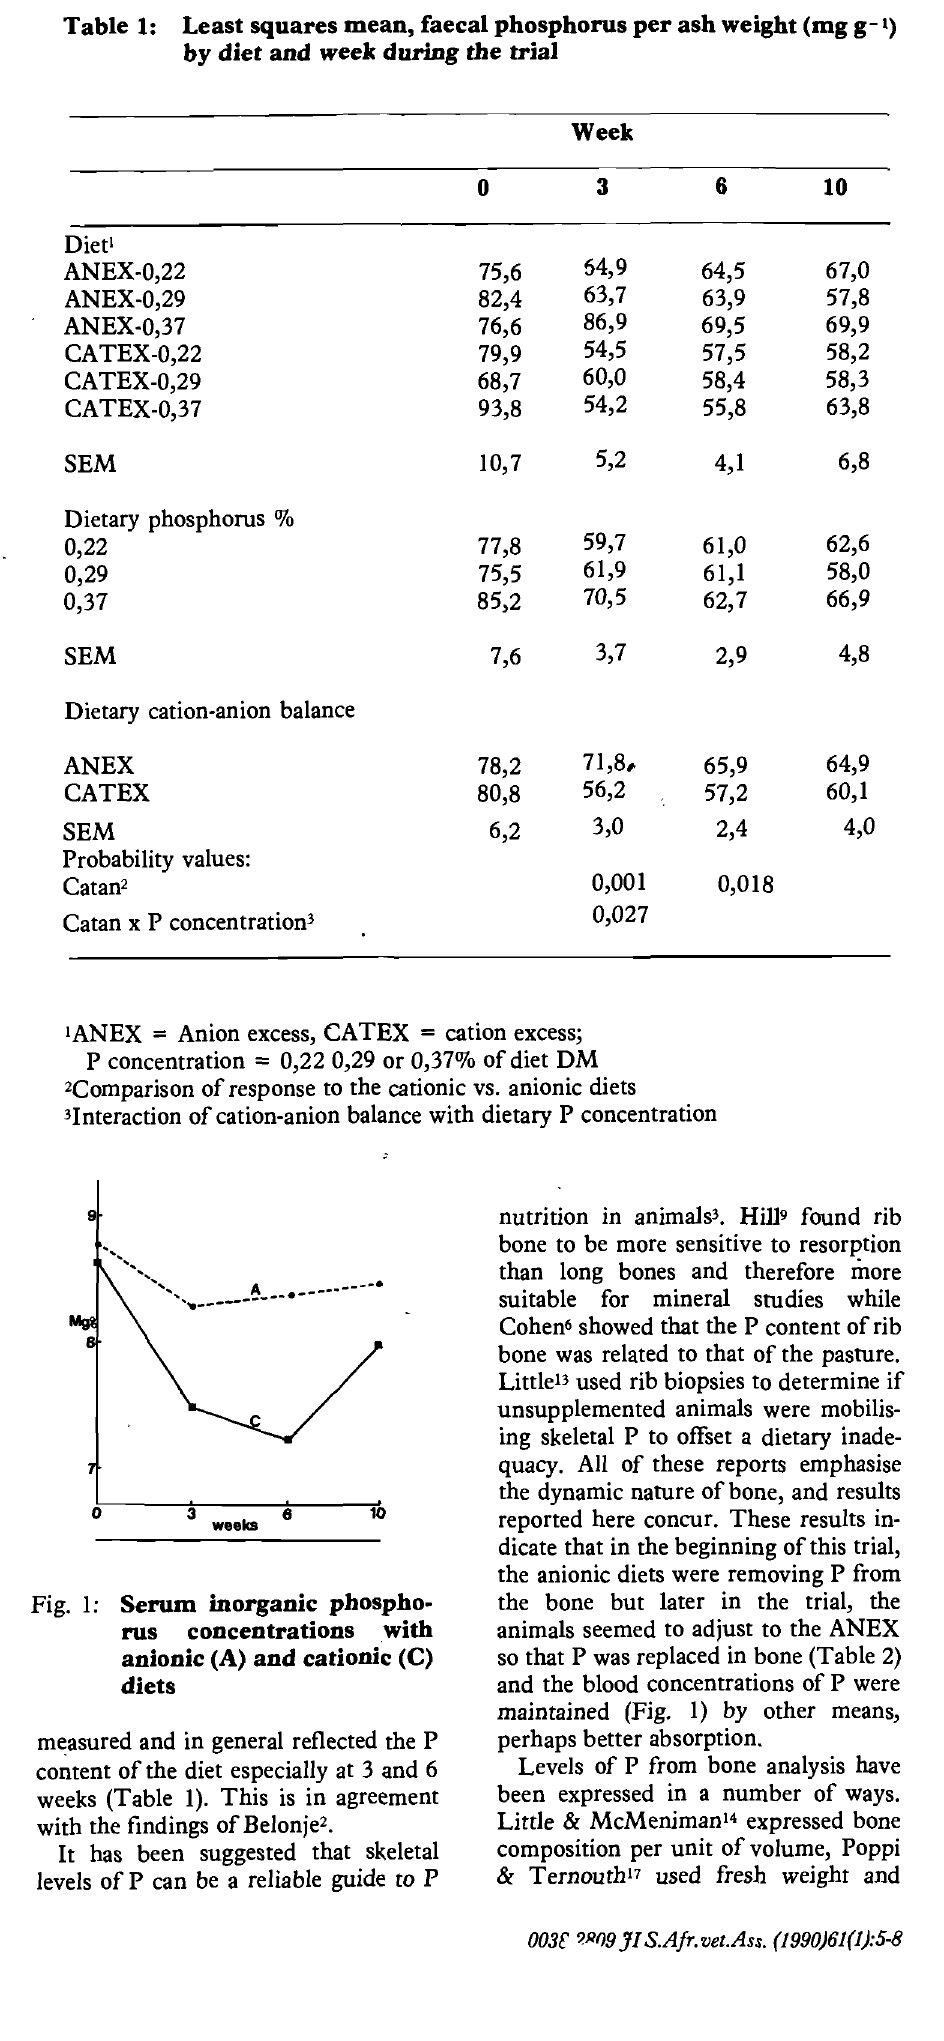
Table 1: Least squares mean, faecal phosphorus per ash weight (mg g-I) by diet and week during the trial